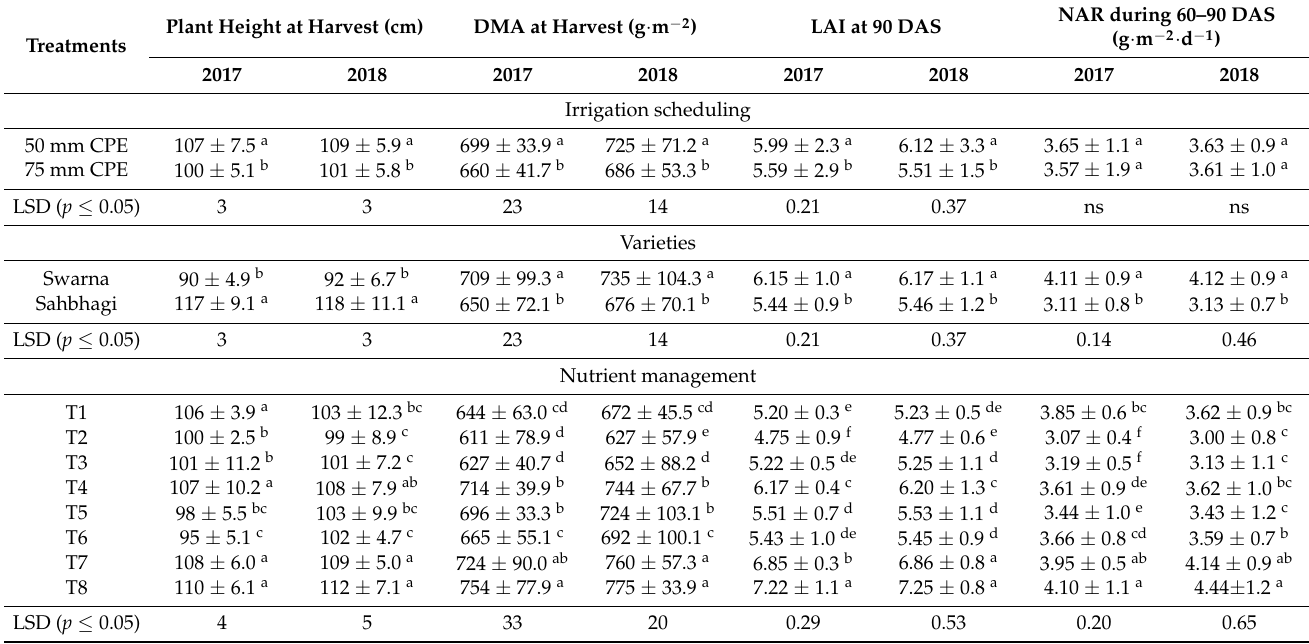
Table 4. The growth of rice is influenced by various irrigation scheduling, varieties and nutrient management practices along with